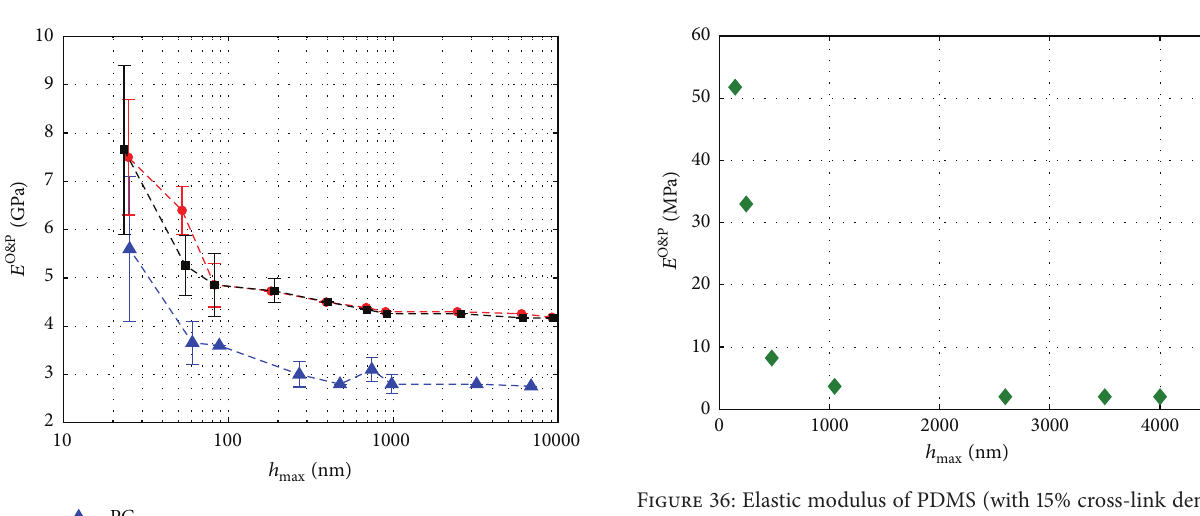
Figure 36: Elastic modulus of PDMS (with 15% cross-link density by weight) determined by a Berkovich tip